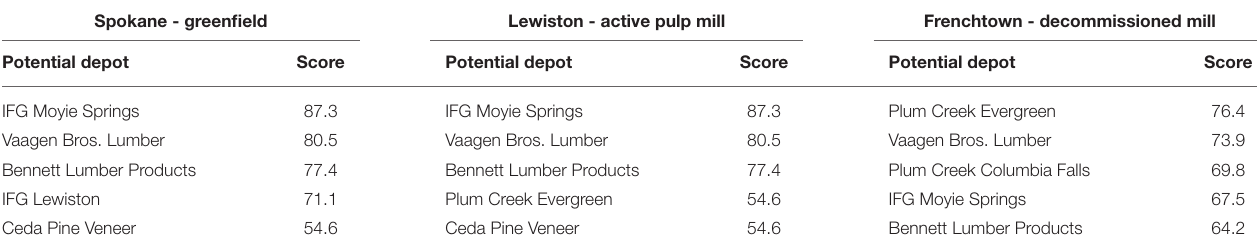
TABLE 6 | Top 5 depot facility scores per biorefinery.